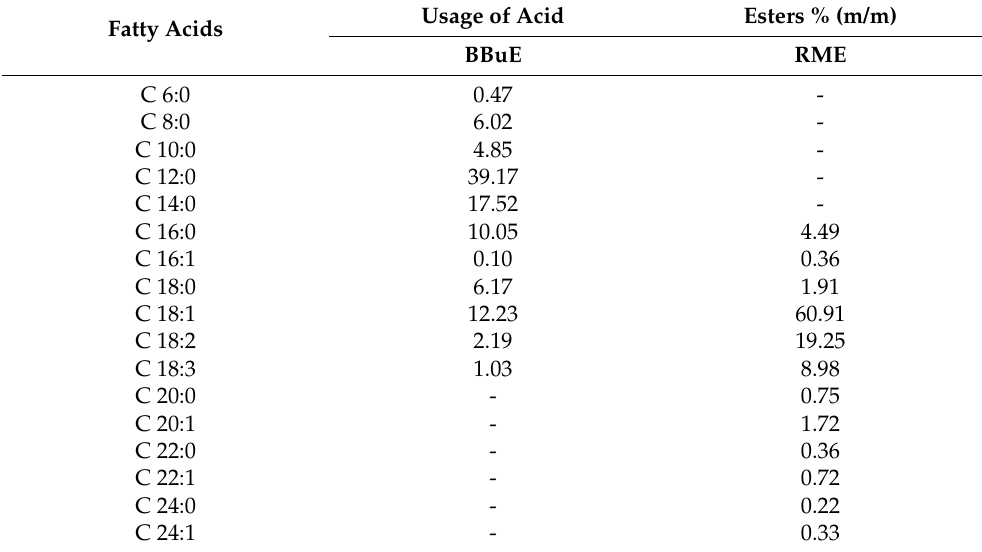
Table 2. Average fatty acid ester composition in BBuE and RME biodiesel.